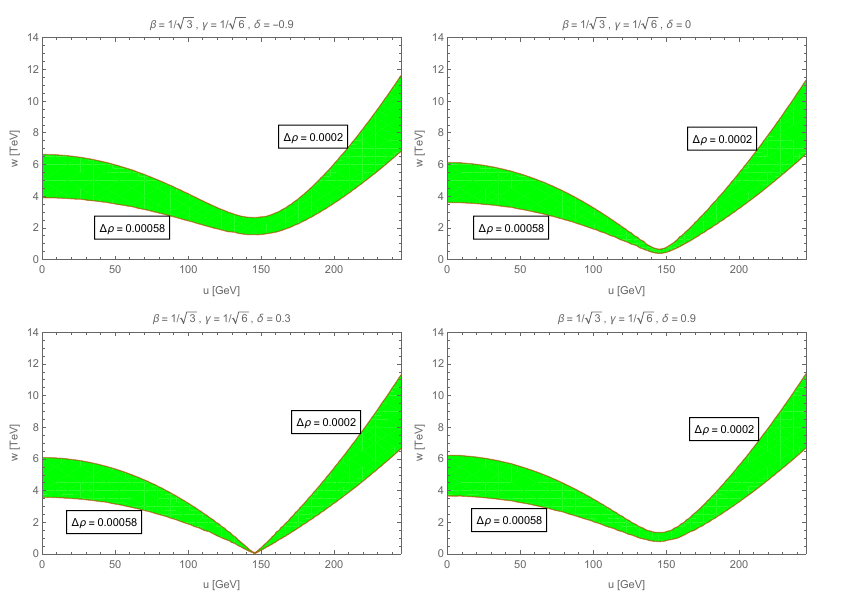
Figure 3 . The ( u, w ) regime that is bounded by the ρ parameter for ( β = 1 / √ 3 , γ = 1 / √ 6 , b = 2 / √ 3, c = −√ 2 / √ 3) and w = 0 . 5Λ V , where the panels from left to right and top to bottom (cid:29) − correspond to δ = 0 . 9 , 0 , 0 . 3, and 0 . 9. −